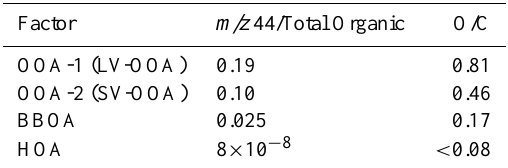
Table 1. O/C calculated for the PMF factors of the organic aerosol